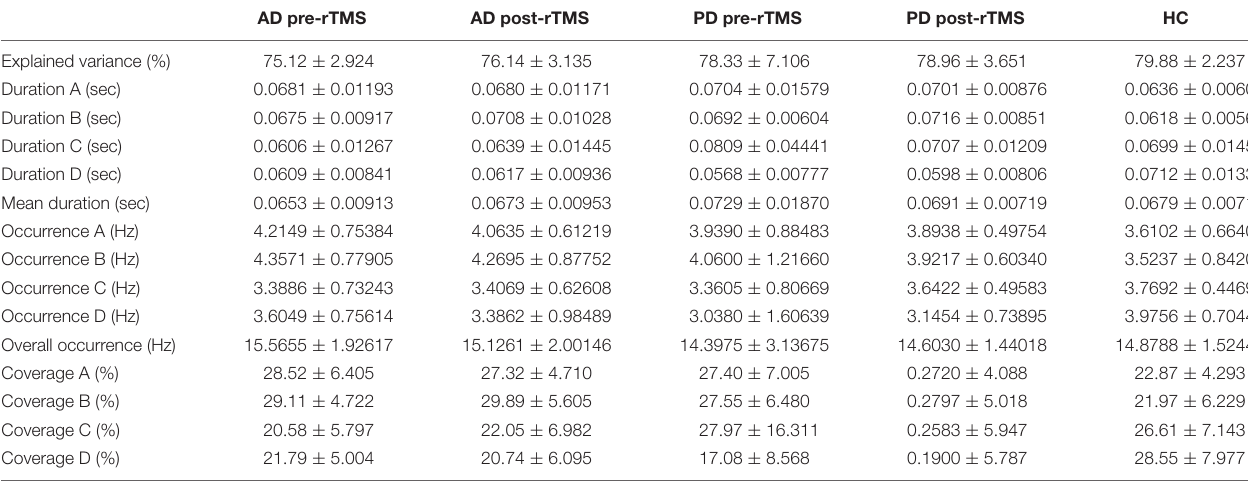
TABLE 3 | Microstates parameters of AD, PD, and control groups at pre and post-rTMS.